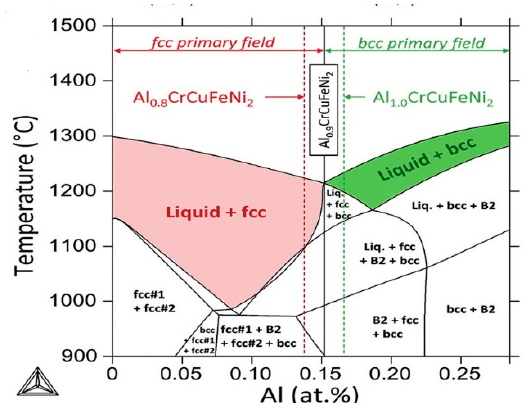
Figure 7. Isopleth for AlXCrCuFeNi2 (with x = 0–2) showing possible phases as a function of Al content and particularly the primary field change with increasing amount of Al added to the CrCuFeNi 2 alloy. Data from [59].